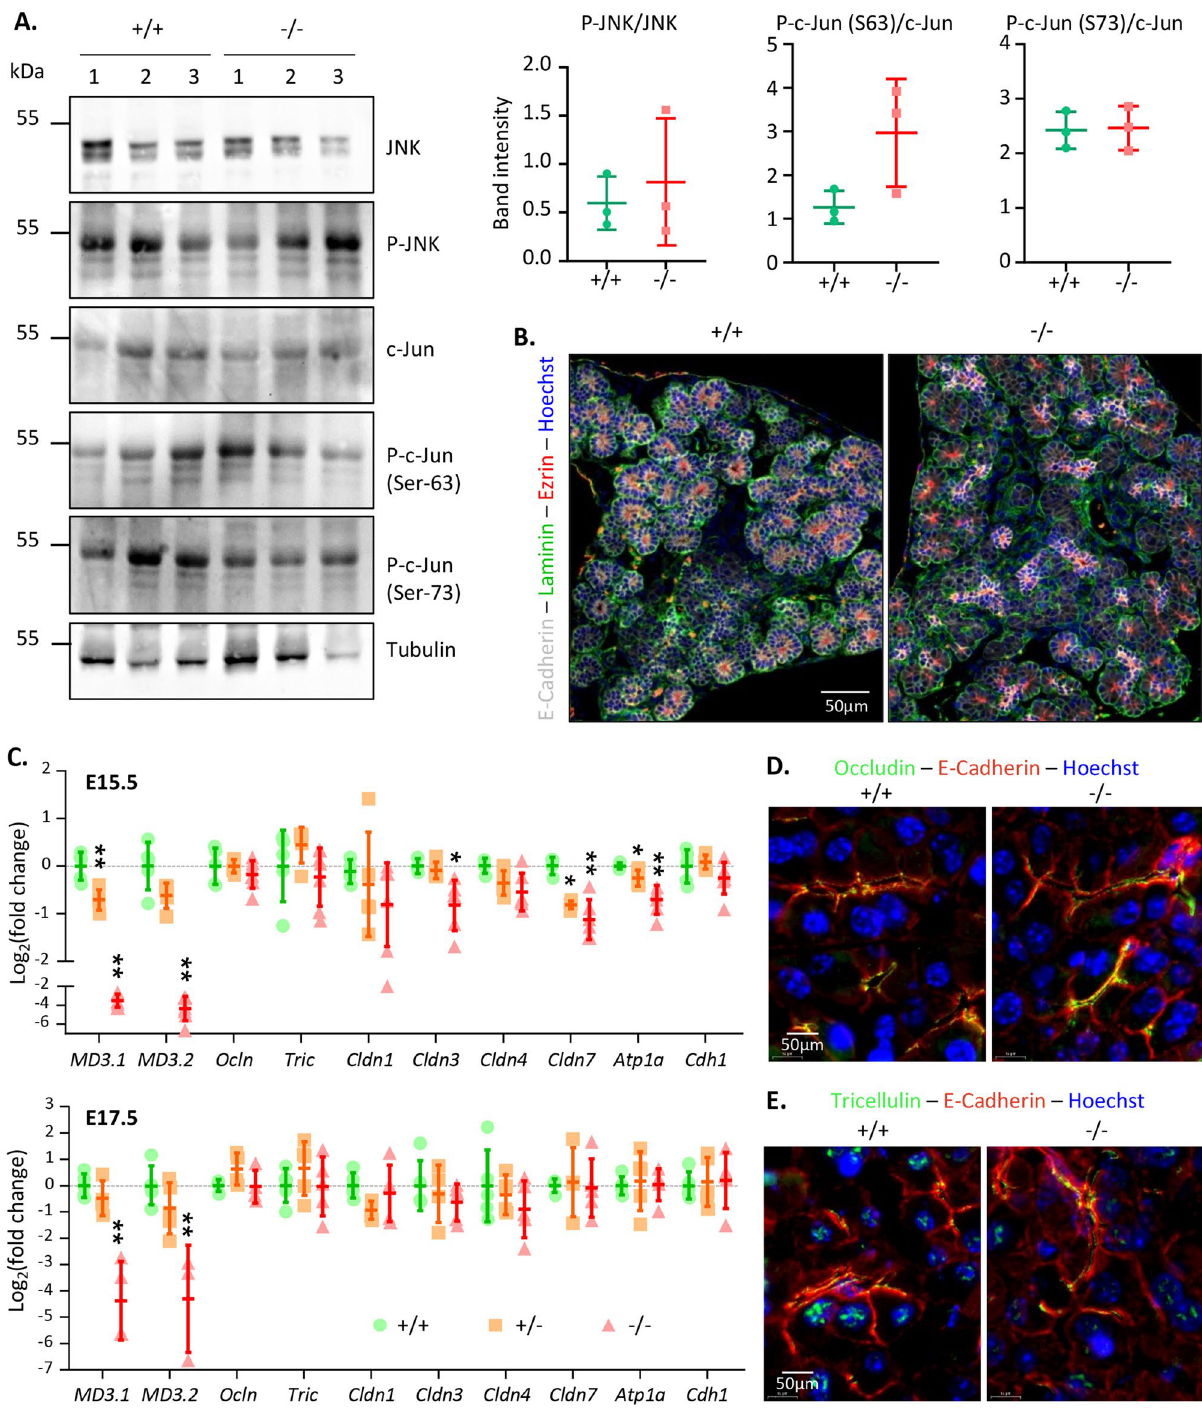
Figure 5. JNK-pathway activity and cell polarity are not altered in the absence of MarvelD3. ( A ) Detection of JNK, c-Jun and their phosphorylated forms in protein extracts from 3 wild-type (+ / +) and 3 MarvelD3 knockout (−/−) pancreata by western blotting. No differences in JNK, phospho-JNK (P-JNK), c-Jun and phospho-c-Jun (P–c-Jun, Ser63 and Ser73) protein levels were observed between wild-type and knockout pancreata. Quantification of the bands (P-JNK/JNK and P–c-Jun/c-Jun) is shown on the right. Full-length blots/gels are presented in Supplementary Fig. 8. ( B ) Cell polarity assessment by immunolabeling of apical (ezrin, red) and basal (laminin, green) markers of epithelial (E-Cadherin, white) cells on E15.5 embryonic pancreas sections. Wild-type (+ / +) and knockout (−/−) pancreatic epithelial cells are polarized. ( C ) RT-qPCR evaluation of tight junction and baso-lateral marker gene expression levels in embryonic (E15.5 and E17.5) pancreata of wild-type (+ / + , green circles), heterozygous (+ /−, orange squares) and MarvelD3 knockout (−/−, red triangles) mice. Transient downregulation of claudin-3 and -7 , and NaK-ATPase ( Atp1a ) is observed in E15.5 knockouts. ( D–E ) Immunolabeling of the TAMP occludin and tricellulin (green) in the wild-type and knockout E15.5 pancreatic epithelium (E-Cadherin, red). The absence of MarvelD3 does not trigger relocalization of the two other